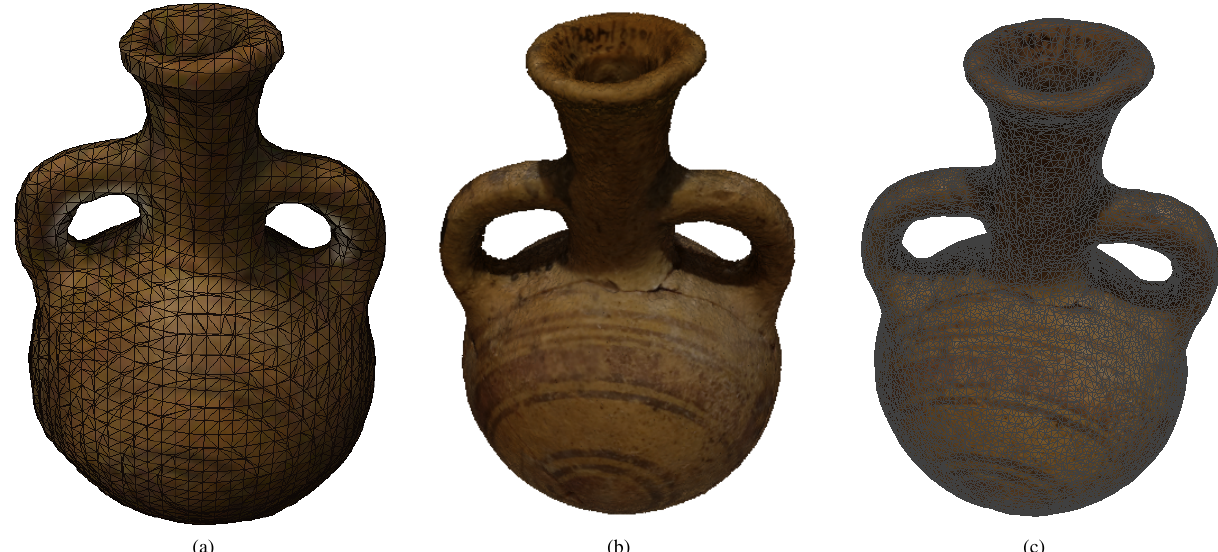
Figure 5: The generated 3D models: (a) solid wireframe visualization of the Structure Sensor model; (b) solid visualization of the high resolution photogrammetric model; (c) solid wireframe visualization of the medium resolution photogrammetric